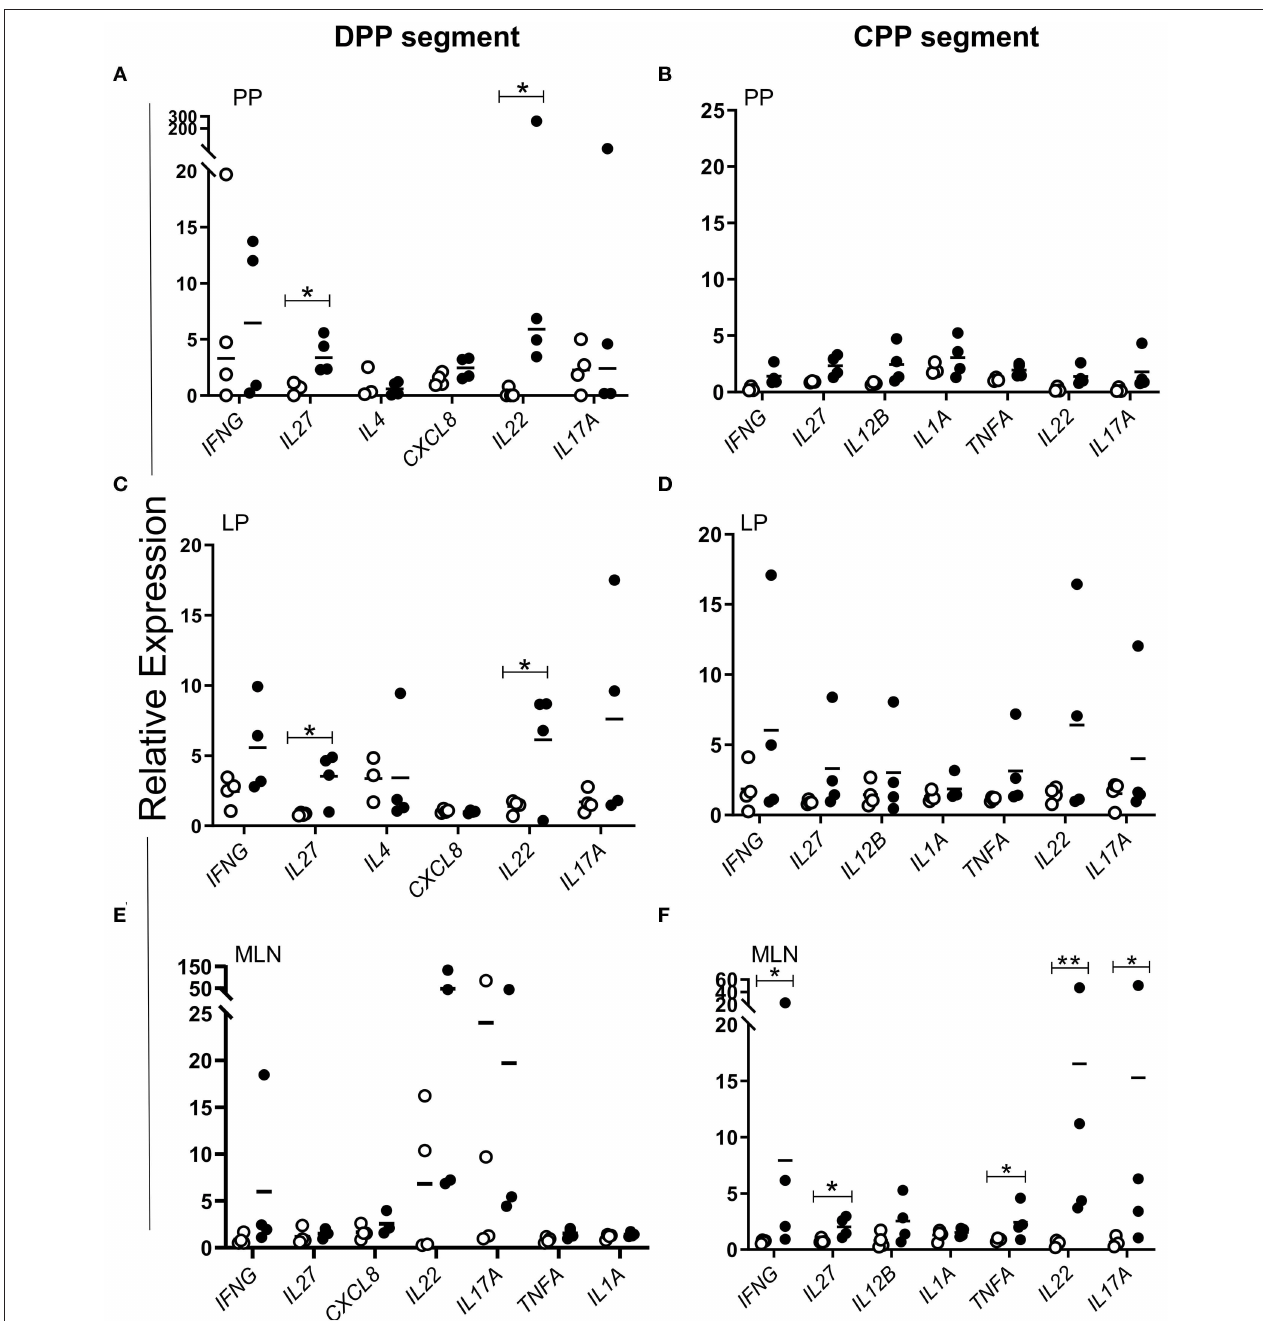
FIGURE 9 | MAP-specific cytokine responses show marked regional and compartmental differences in mucosal immune response to persistent MAP infection. Freshly isolated (A,B) PP and (C,D) LP cells from MAP-infected (black dots) DPP ( n = 4) and CPP ( n = 4) segments and PBS control (white circles) DPP ( n = 4) and CPP ( n = 4) segments, and (E,F) cells from the draining MLN were stimulated in vitro with MAP whole-cell lysate (1 µ g/mL; 2 × 10 6 cells). Cytokine transcript was quantified in resting and stimulated cells to determine relative expression. Each data point represents the relative expression for each individual animal. * p < 0.05, ** p < 0.01. p values were calculated using Student’s t test for all datasets with the exception of IL22 in PP cells in which a Mann-Whitney test was applied. PP, Peyer’s patch; CPP, continuous PP; DPP, discrete PP; LP, lamina propria; MLN, mesenteric lymph